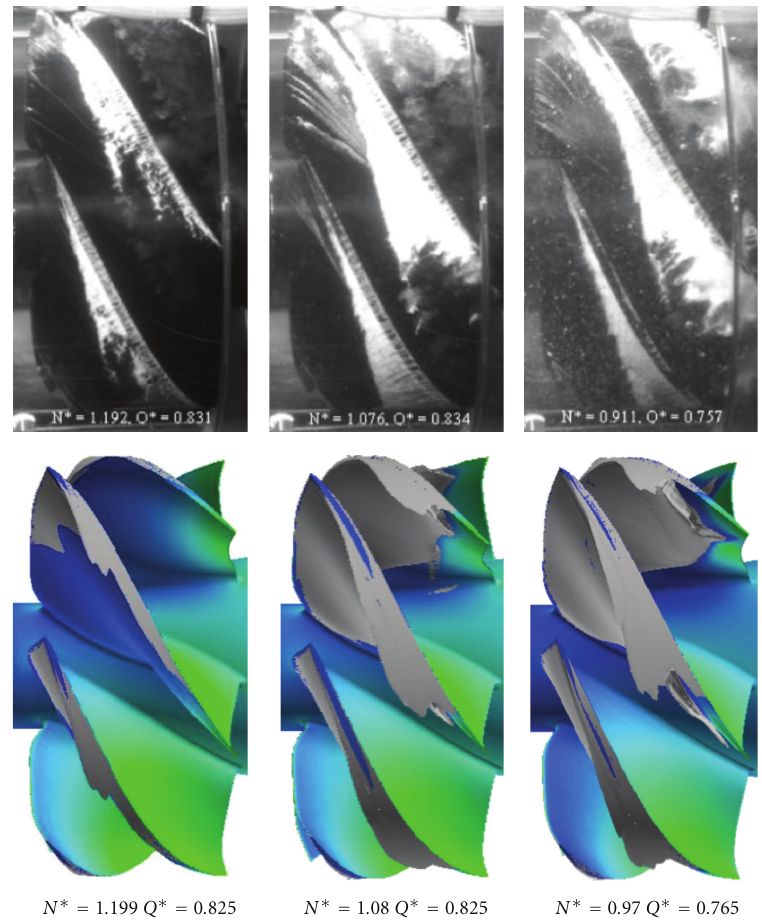
Figure 5: Waterjet pump, AXWJ-2, tip leakage cavitation patterns. Photographs from testing [20] with transparent shroud and results from RANS-based modeling (shroud not shown). Solutions are colored by pressure on surfaces. Cavitation is illustrated with α v = 0 . 5 isosurface.